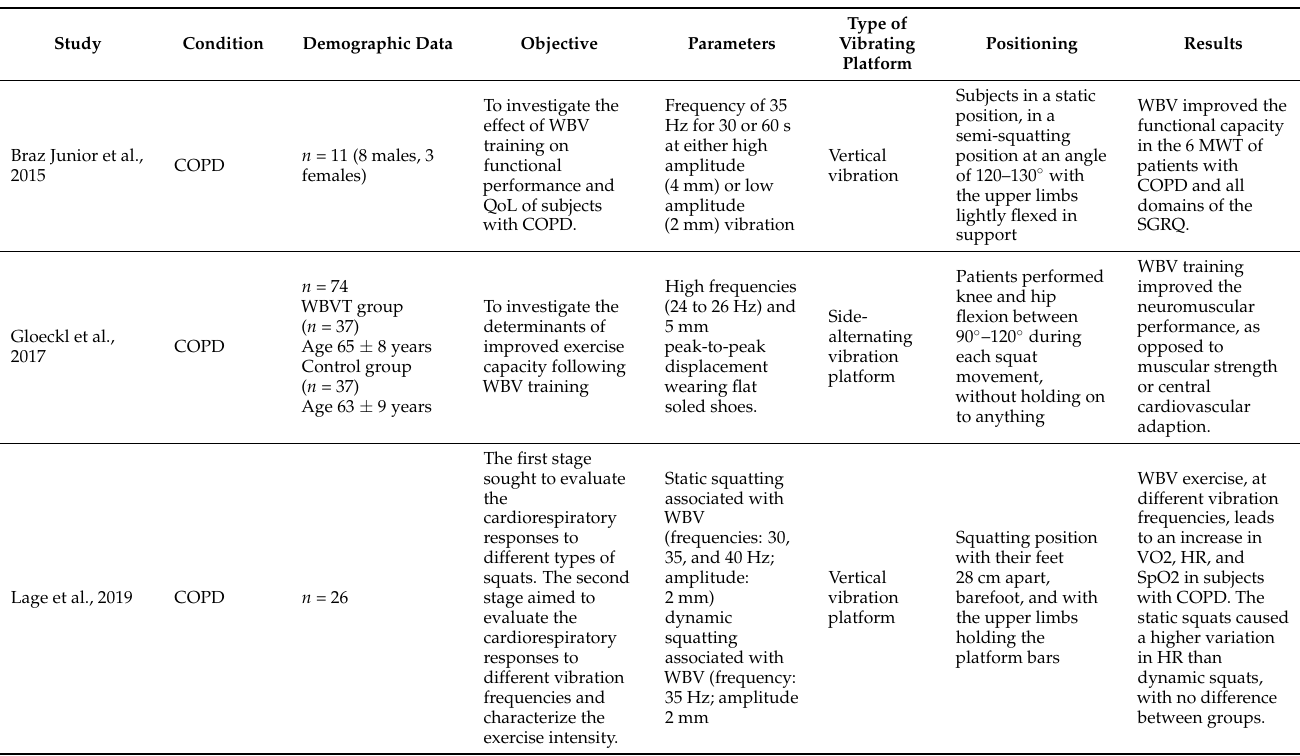
Table 7. Different populations submitted to WBV exercise, with symptoms also observed in the COVID-19 patients: lungs capacity impairment.